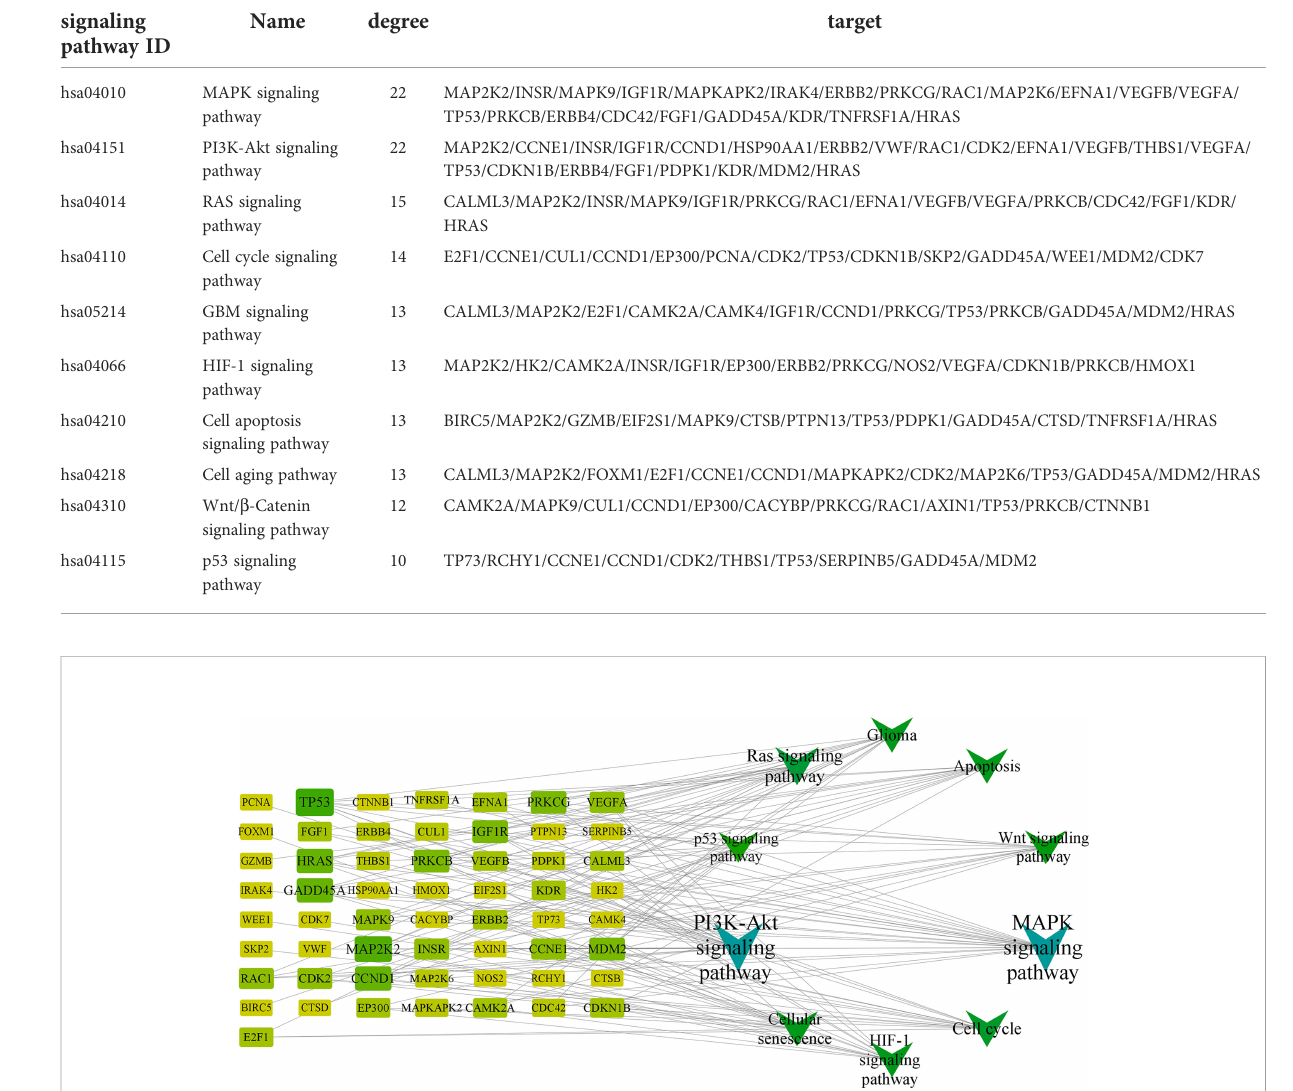
TABLE 2 KEGG enrichment analysis of the RXLD-related GBM targets (Top 10).